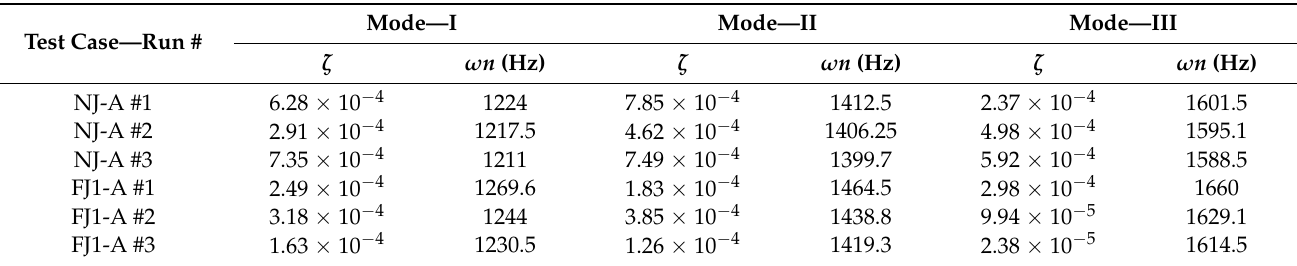
Table 1. Testing scenarios (at 80 Hz–600 mVpp) for detecting failing joints in